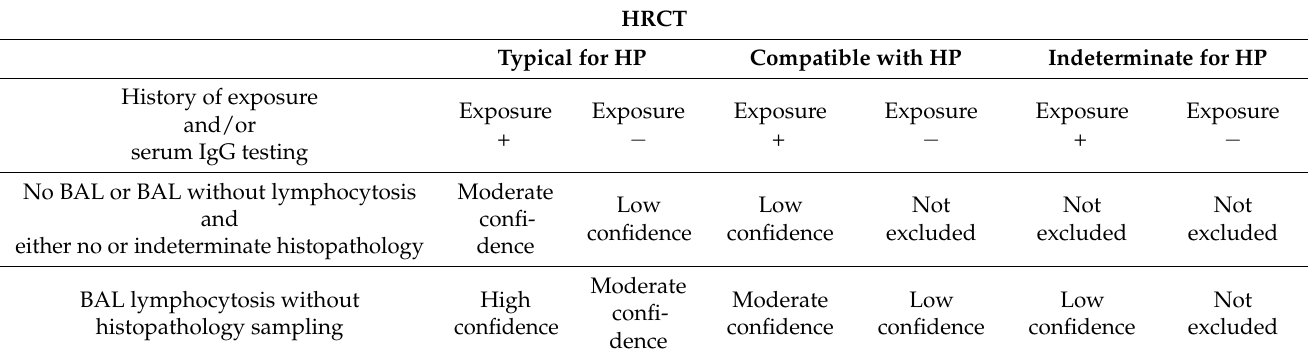
Table 6. Algorithmic approach to diagnostic confidence for hypersensitivity pneumonitis based on exposure, BAL, histopathology, and imaging features. HRCT Typical for HP Compatible with HP Indeterminate for